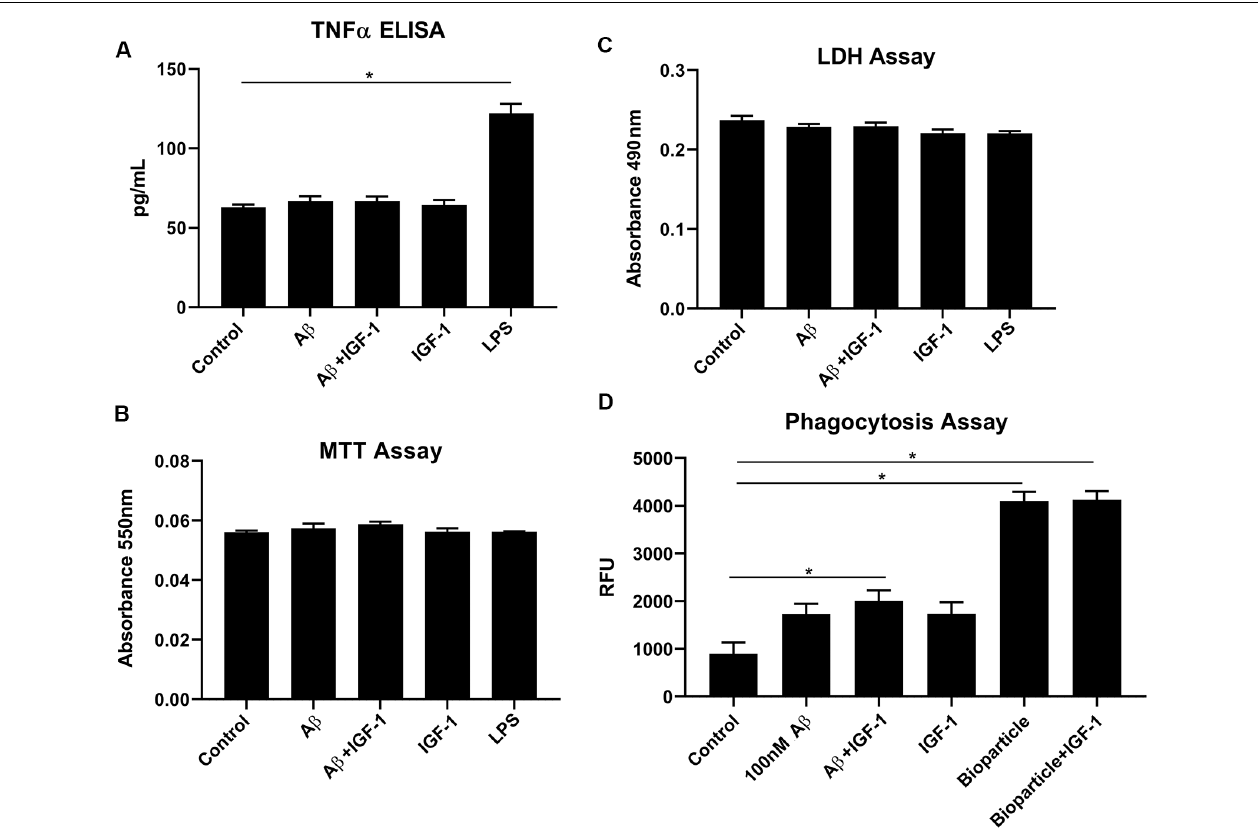
FIGURE 6 | IGF-1 stimulation did not alter microglial cytokine secretory ability but modestly altered uptake in response to A β stimulation. Microglia were isolated from 10-month-old C57BL/6 wild type brains and stimulated in serum-free DMEM/F12 for 24 h with or without 100 nM A β 42, 25 ng/ml LPS or 100 ng/ml IGF-1. (A) TNF- α secretion was quantified via ELISA from the media, Graphs are means values ± SEM with replicates of 8, * p < 0.05. Representative data from three independent experiments are shown. One-way ANOVA indicates TNF- α F (6,28) = 41.40 and p < 0.0001. Multiple comparisons were performed via Dunnet’s test. (B) Mitochondrial dehydrogenase activity in the cells was assessed via an MTT assay. Graphs are mean values ± SEM with replicates of 8. Representative data from three independent experiments are shown. One-way ANOVA indicates MTT F (6,28) = 1.41 and p = 0.2458. Multiple comparisons were performed via Dunnet’s test. (C) Cell viability was quantified by an LDH release assay. Graphs are mean values ± SEM with replicates of 8. Representative data from three independent experiments are shown. One-way ANOVA indicate LDH F (6,28) = 2.7 and p = 0.0339. Multiple comparisons were performed via Dunnet’s test. (D) 1 µ M FITC-A β 42 or 0.25 mg/ml FITC E. coli bioparticle positive control were added to the cells for 6 h with or without 100 ng/ml IGF-1 to assess phagocytic uptake. Graphs are mean values ± SEM with replicates of 8, * p < 0.05. Representative data from three independent experiments are shown. One-way ANOVA F (5,35) = 39.33 and p < 0.0001. Multiple comparisons were performed via Dunnet’s